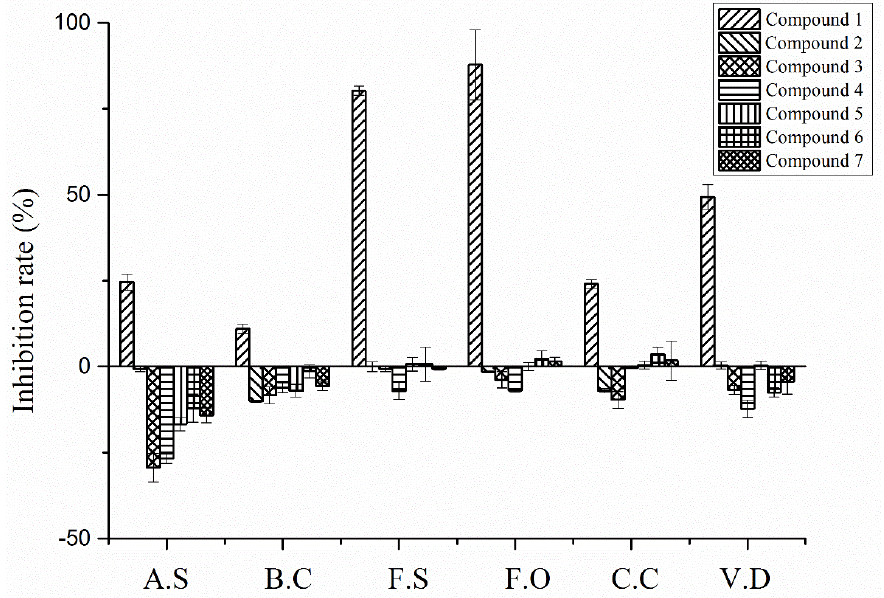
Figure 7. The effects of compounds 1 – 7 against the potato pathogens including A. solani , B. cinerea , F. solani , F. oxysporum , C. coccodes , and V. dahlia at a concentration of 200 µ g/mL.